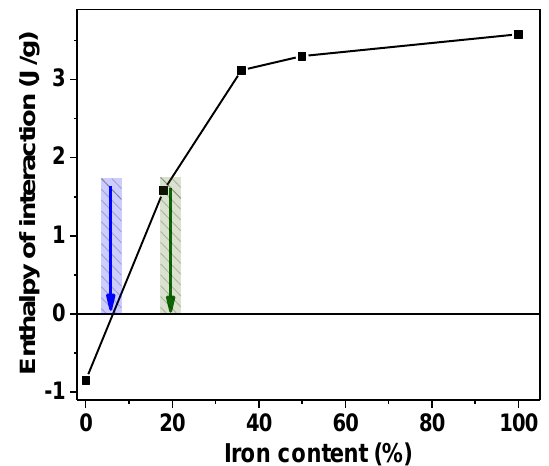
Figure 4. Indicative values of the enthalpy of interaction of GE polymer with zero-valent metal MNPs: Ni, Ni82Fe18, Ni64Fe36, Ni50Fe50, Fe. Blue arrow indicates zero-enthalpy of interaction composition and green arrow indicates the composition with maximum magnetic permeability (at about 79% nickel).